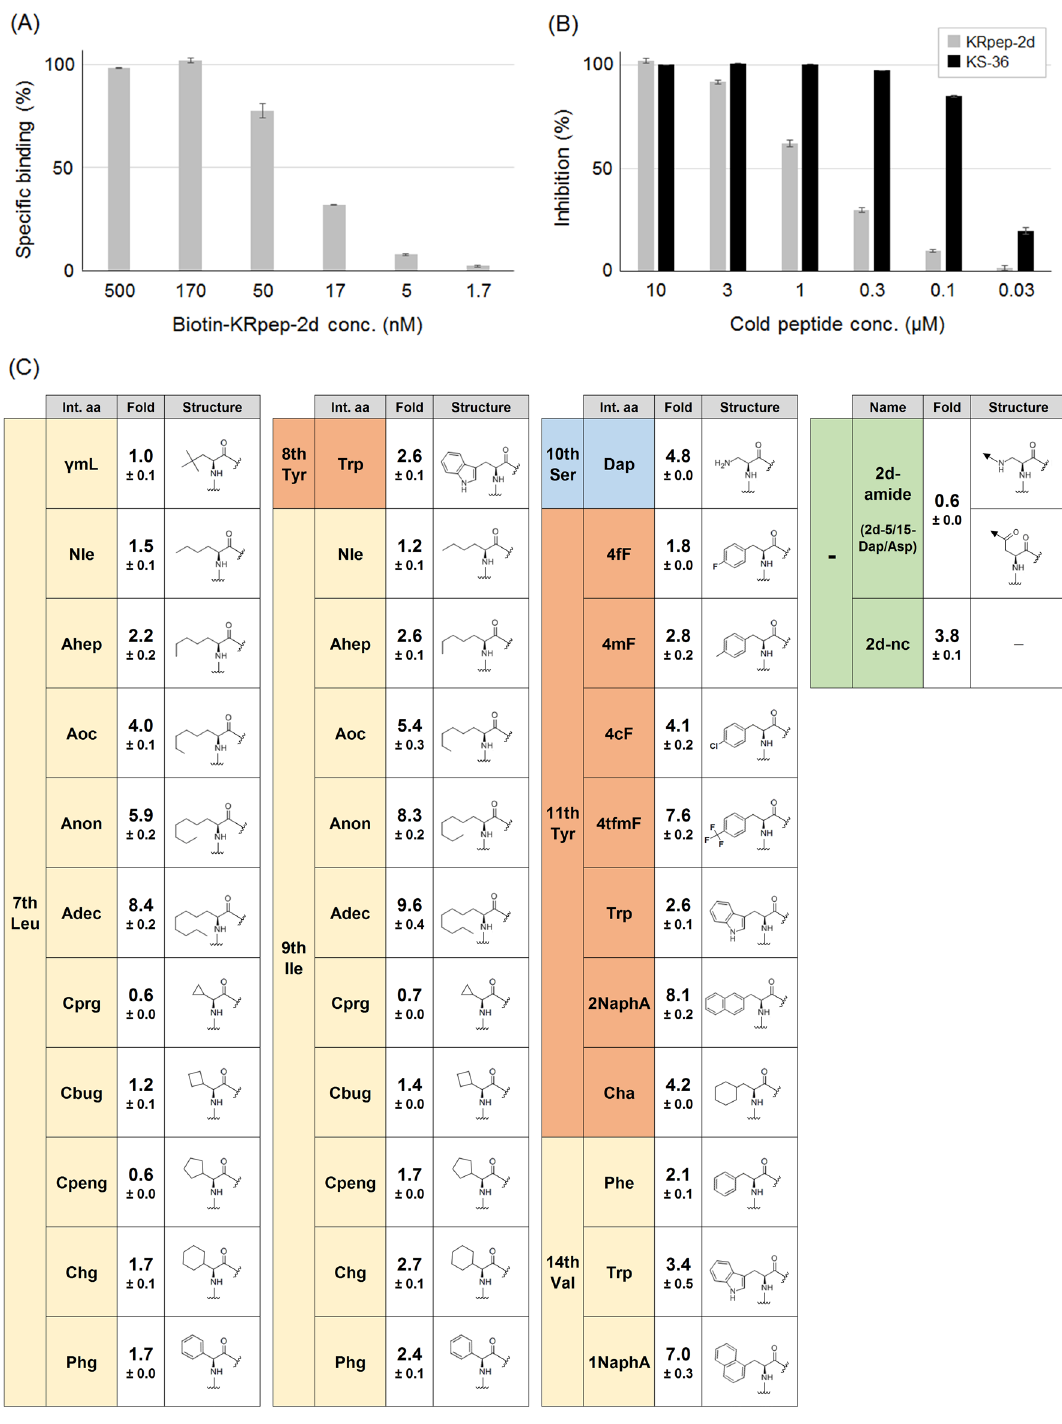
Figure 3. Screening of KRpep-2d derivatives. ( A ) K-Ras(G12D)-binding activity of Biotin-KRpep-2d in ELISA (n = 4, ± SEM). ( B ) Competitive inhibition activities of KRpep-2d and KS-36 against the interaction of plate- coated K-Ras(G12D) and Biotin-KRpep-2d (100 nM) (n = 4, ± SEM). ( C ) Amino acid structures introduced into KRpep-2d derivatives and their K-Ras(G12D)-binding activities. Positions of the substituted amino acids in KRpep-2d and introduced amino acids are listed. K-Ras(G12D)-binding activities are listed as fold-value compared to the parental KRpep-2d set as 1.0 (n = 4, ± SEM). 2d-amide is an amide bond (Dap 5 –Asp 15 ) cyclized KRpep-2d, and 2d-nc is main chain cyclized